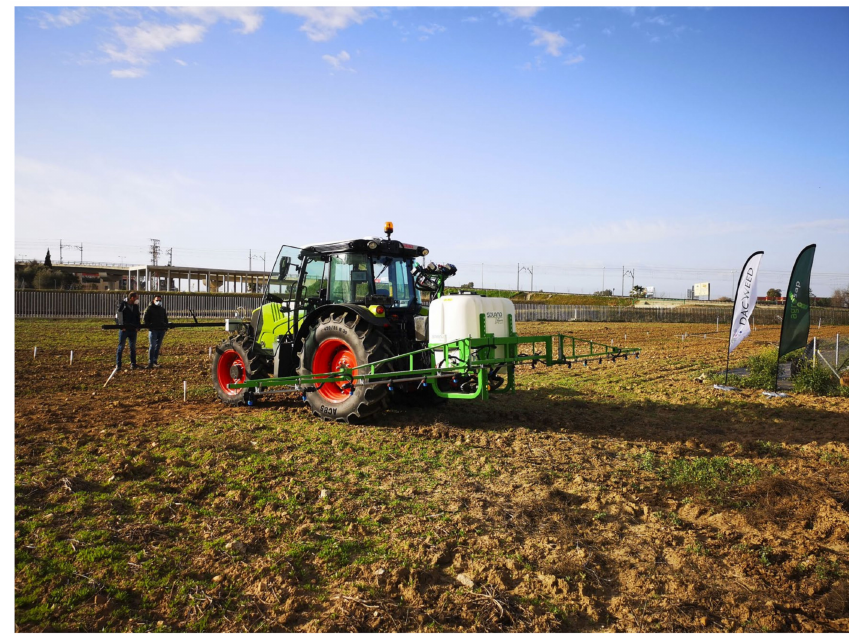
Figure 7. Setting of the project DACWEED source: